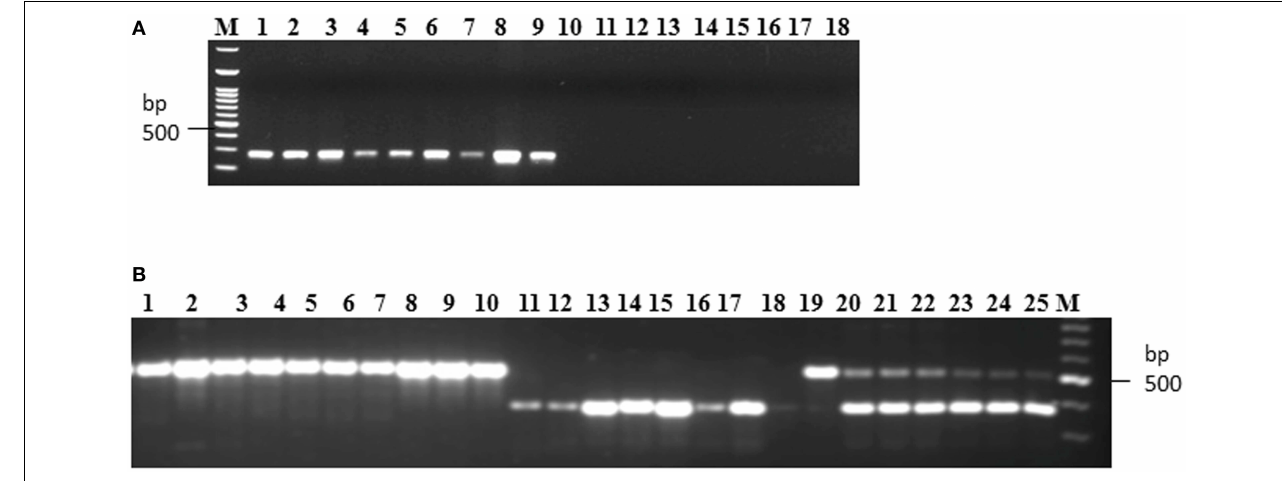
FIGURE 7 | PCR amplification of rice lines with the dominant and co-dominant PCR marker. (A) PCR amplification with the dominant marker (D163_F and D163_R) in 18 rice lines. Lanes 1–9: presence of band in rice lines (Acharmati, Aditya, Ananda, Beesginsali, Bidarlocal-2, Dhanaprasad, Gautam, Himdhan, and Pusa sugandh 5); lanes 10–18: absence of band in rice lines.(HR-12, TP-309, Co-39, Nipponbare, Shiva, Satti, Pusa basmati-1, Ram Jawain-100, and Sathia-2) (B) PCR amplification with the co-dominant